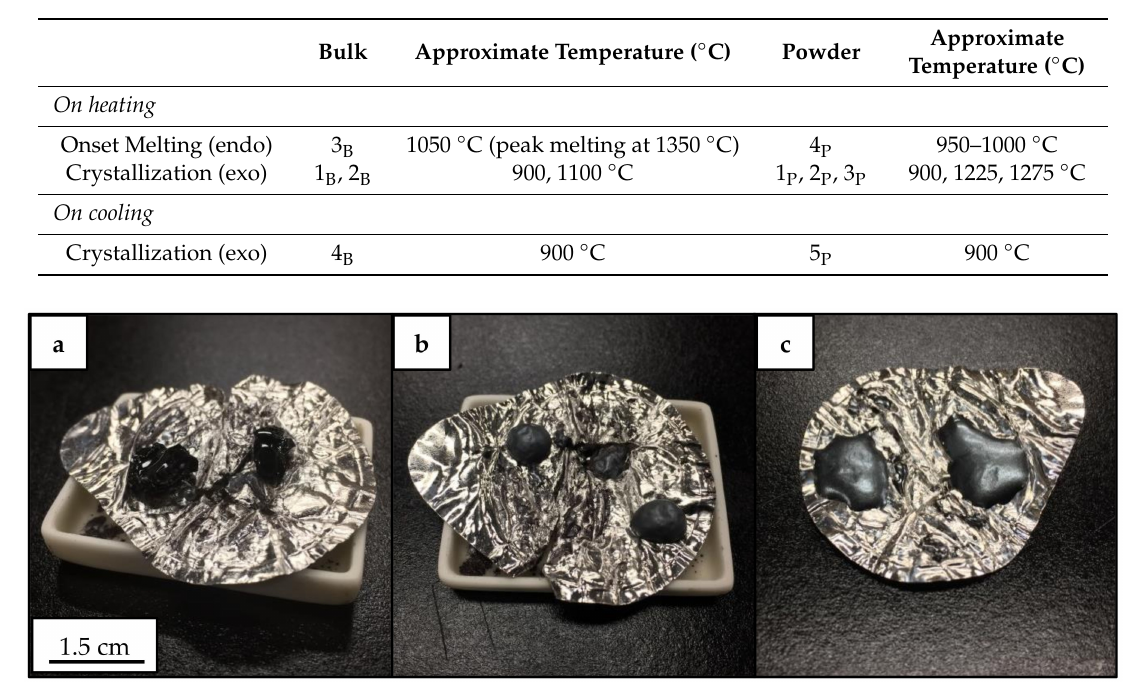
Figure 2. Bulk (bold line) and powder (dashed line) volcanic ash glass di ff erential thermal analysis (DTA) curves with a ramp rate of 10 ◦ C / min. Labels 1 B , 2 B , 1 P , 2 P , and 3 P correspond to crystallization in the bulk (B) and powder (P) samples on heating. Labels 3 B and 4 P show the onset of melting. Labels 4 B and 5 P indicate solidification of molten glass upon cooling. Table 2. List of DTA thermal events presented in Figure 2 for the volcanic ash glass.